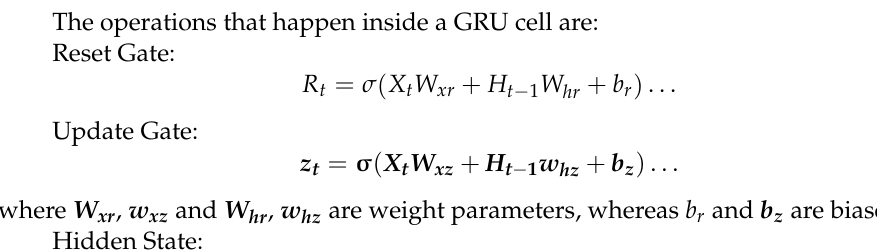
Figure 6. ( a ) Architecture of the Bi-GRU neural network. ( b ) Functions inside a single GRU cell.